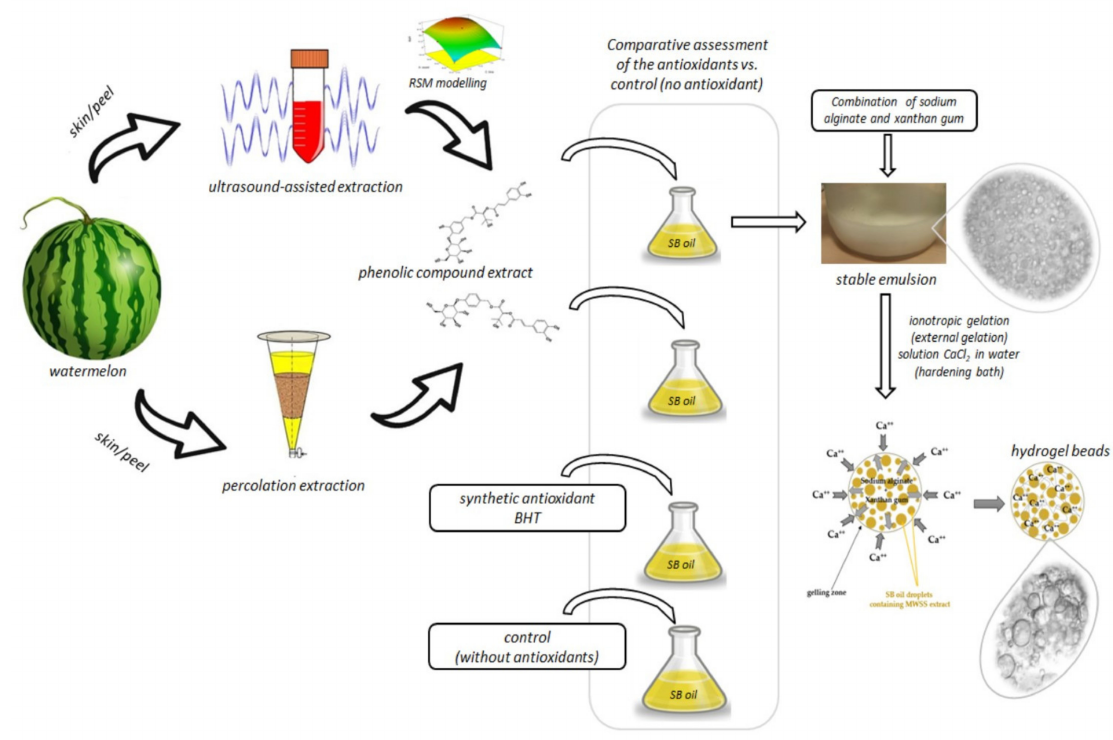
Figure 1. Experimental